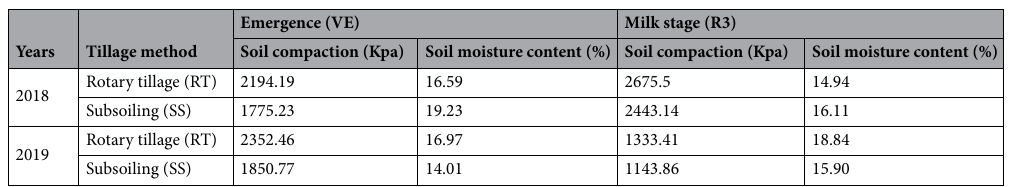
Table 1. Main soil physical properties in the test